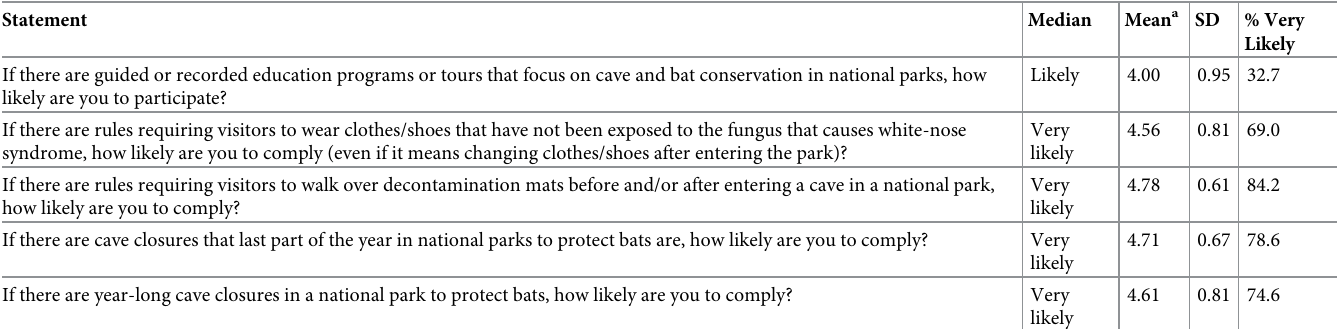
Table 1. Visitor behavioral intent about white-nose syndrome preventive actions used by the U.S. National Park Service,